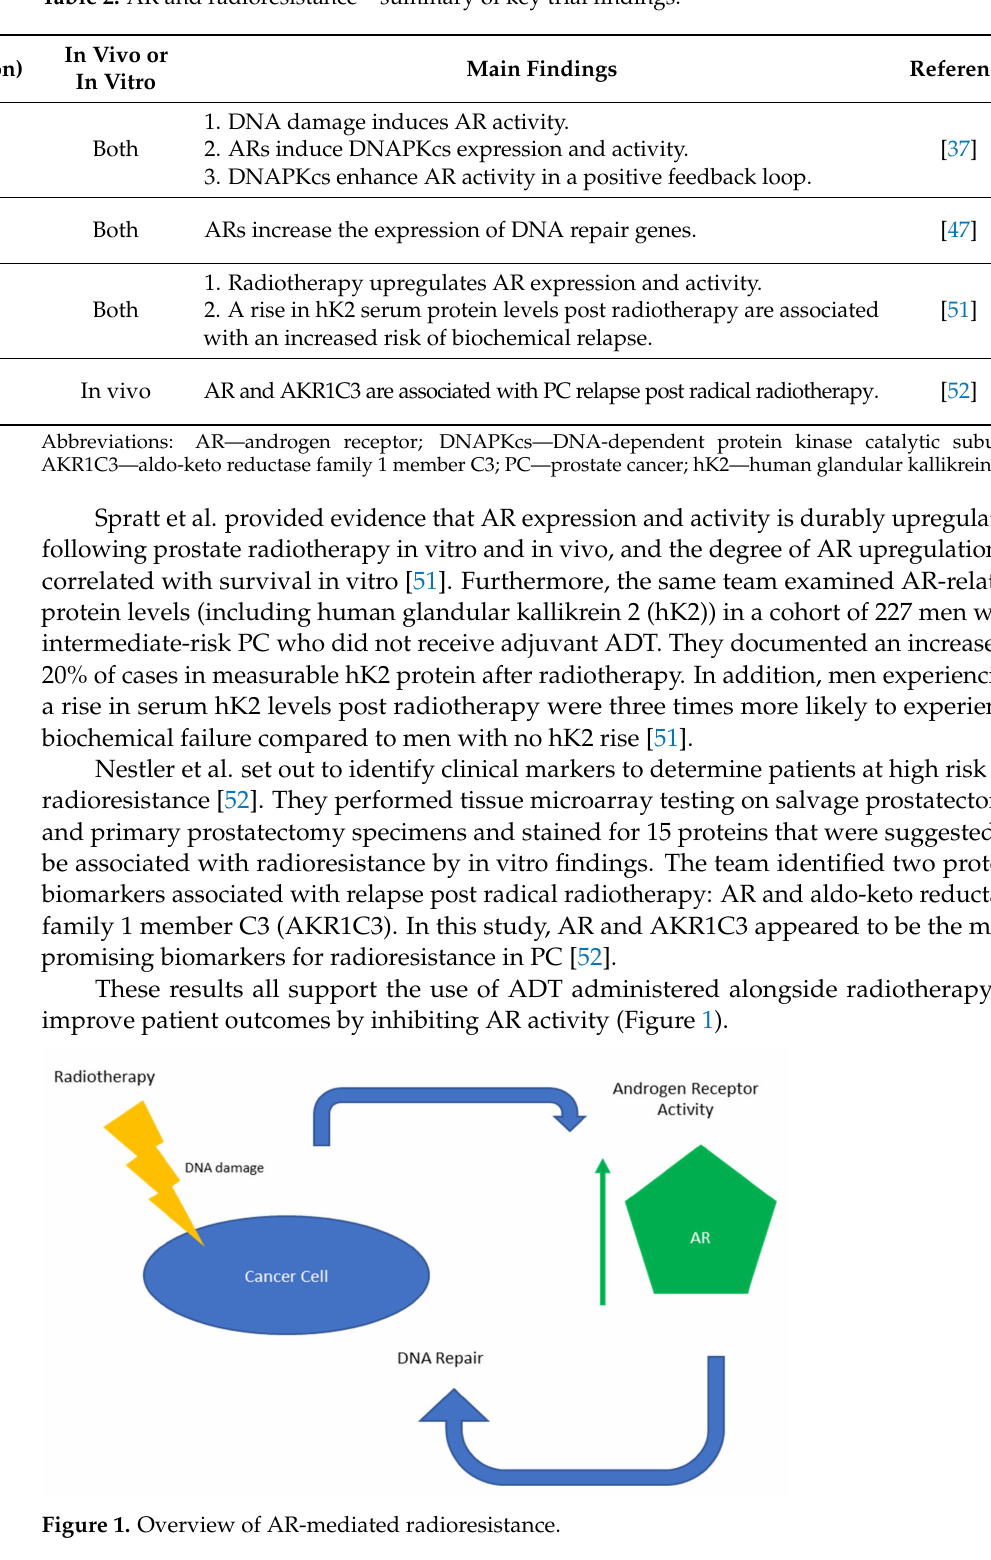
Table 2. AR and radioresistance—summary of key trial findings.